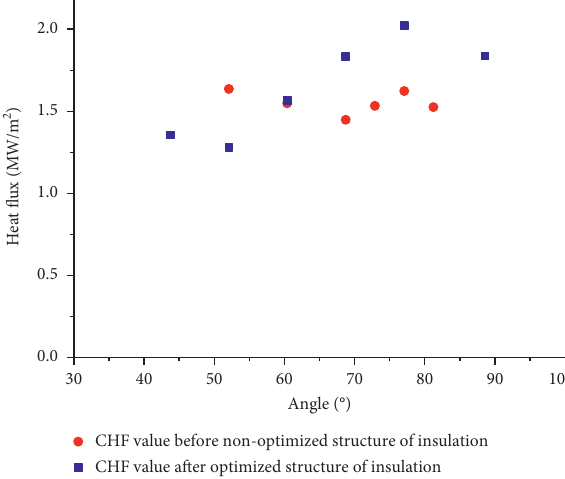
Figure 11: Comparison of CHF values between optimized and nonoptimized flow channels.